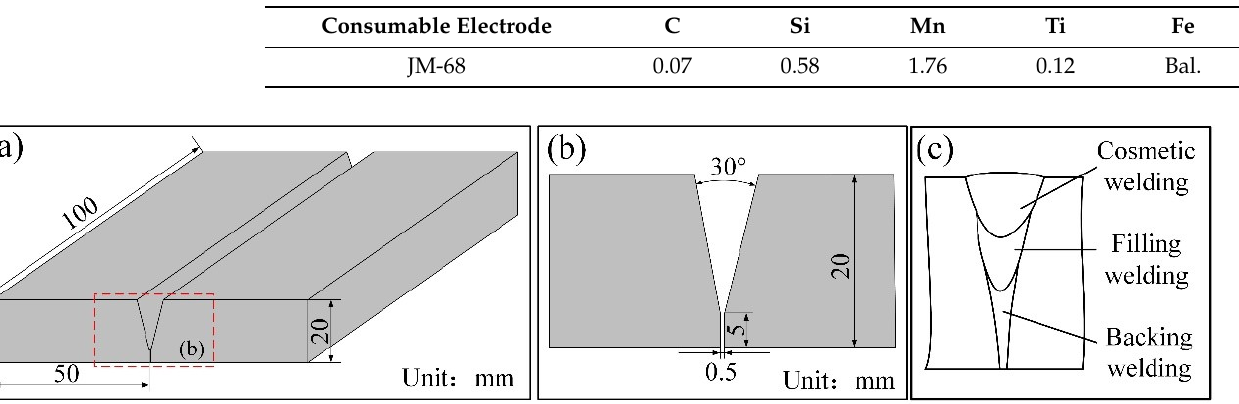
Figure 2. Schematic diagram: ( a ) Dimensions of the workpiece; ( b ) Sizes of the groove; ( c ) weld cross-section.